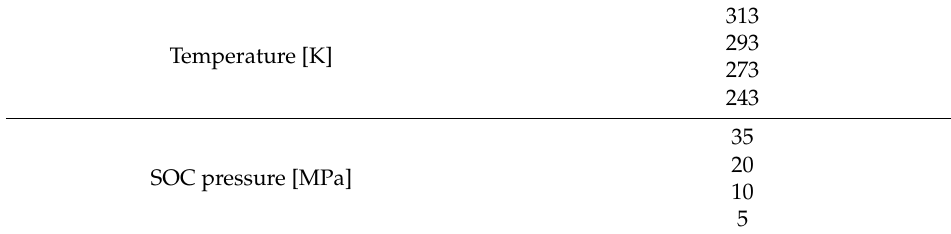
Table 3. Calculation